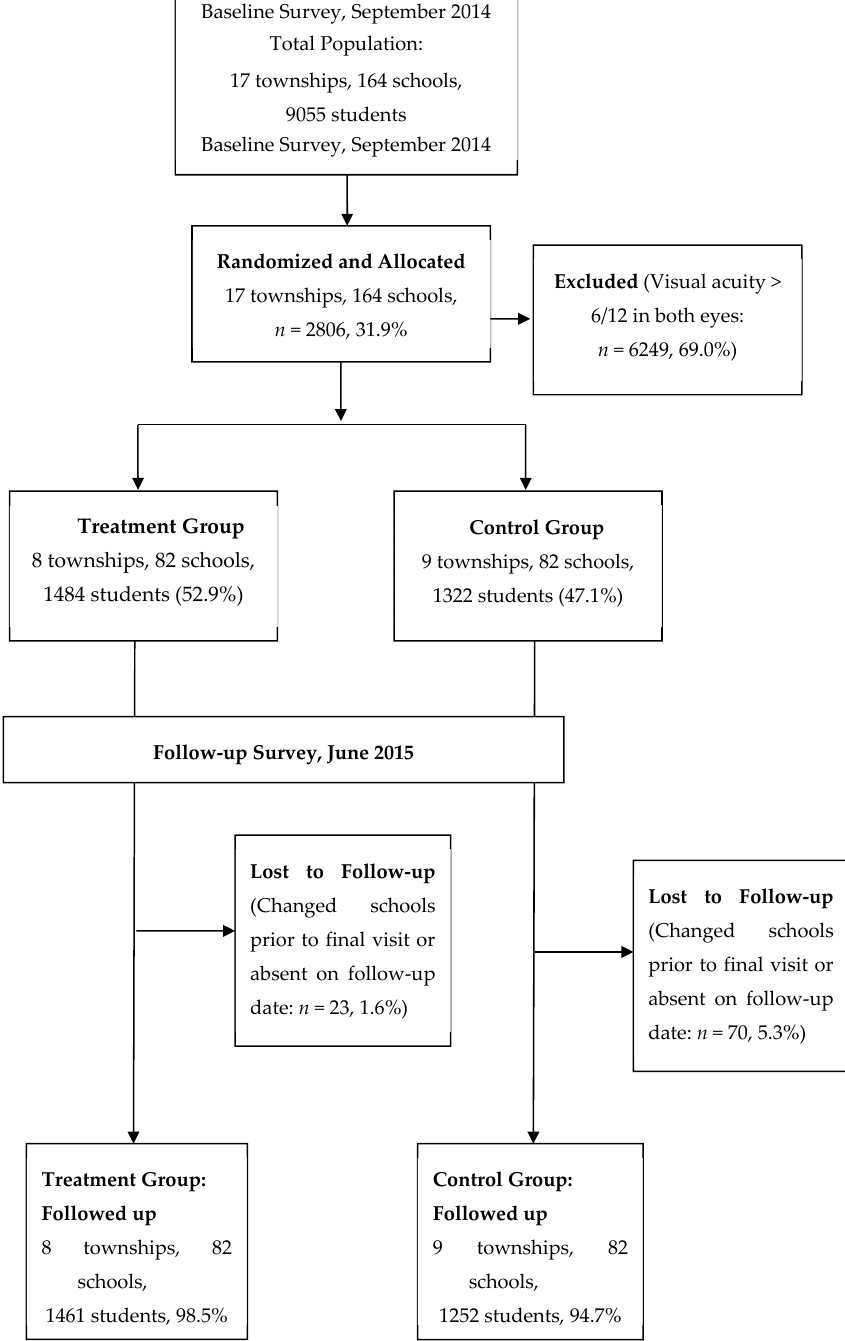
Figure 1. Flow Enrollment Chat and Progress of the Trial.